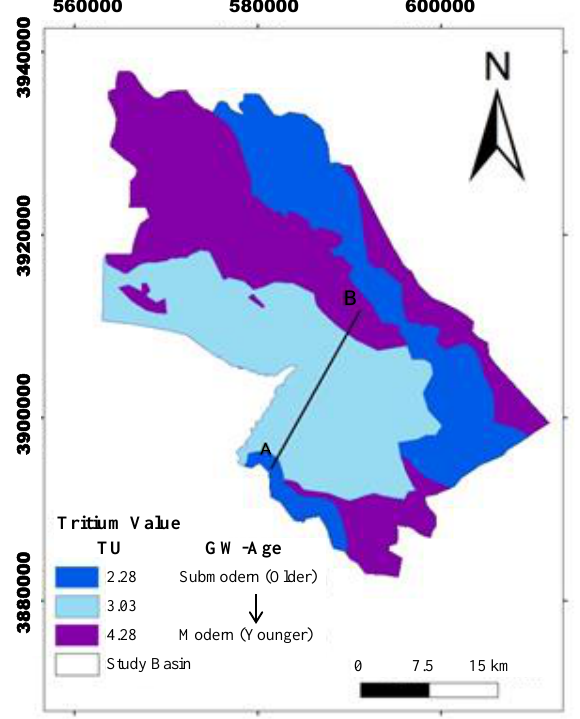
Figure 5. Groundwater age and Tritium value of aquifers at the HSB.